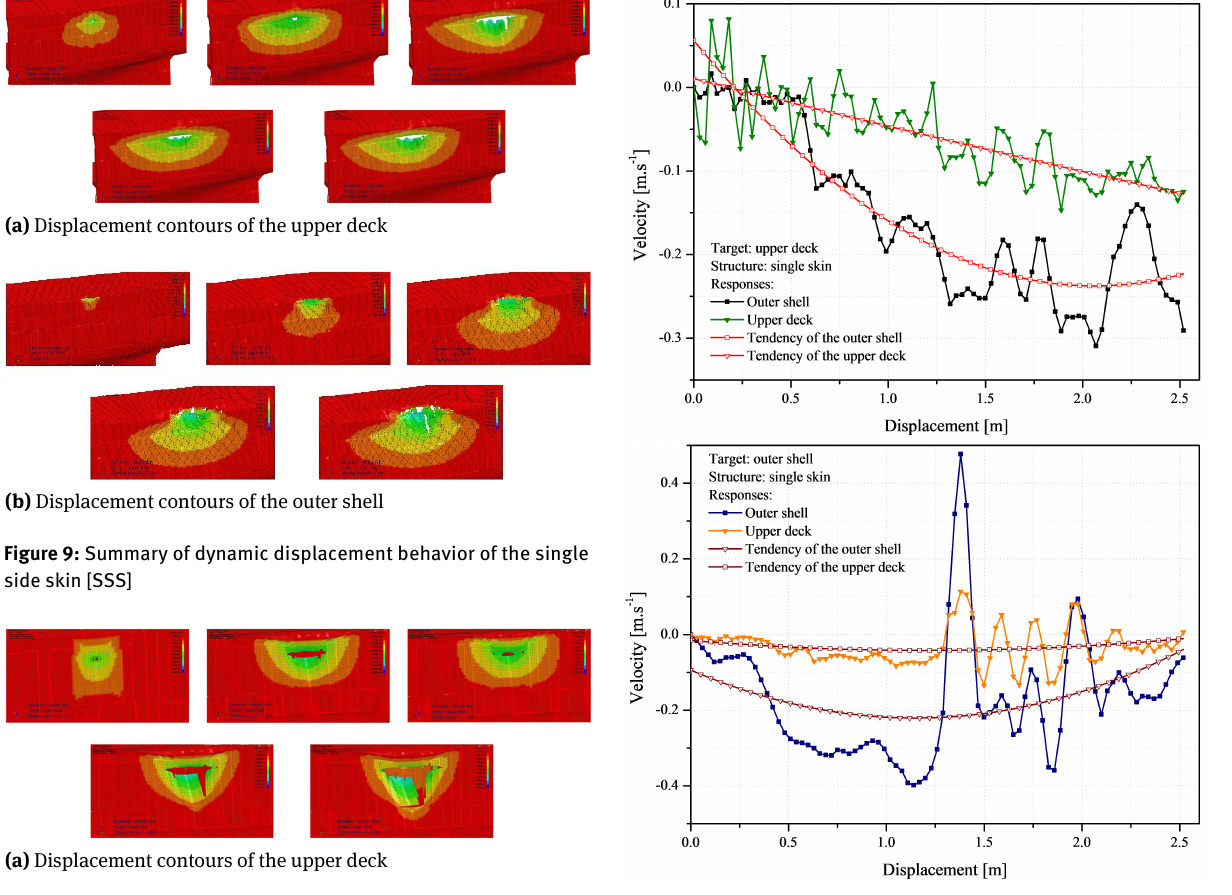
Figure 11: Velocity of the targets on single side skin [SSS] during side impact